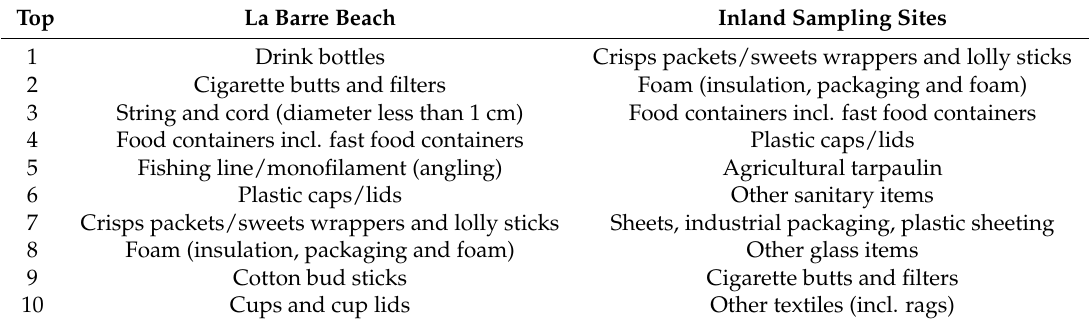
Table 3. Top 10 identifiable items for La Barre beach and inland sampling sites.